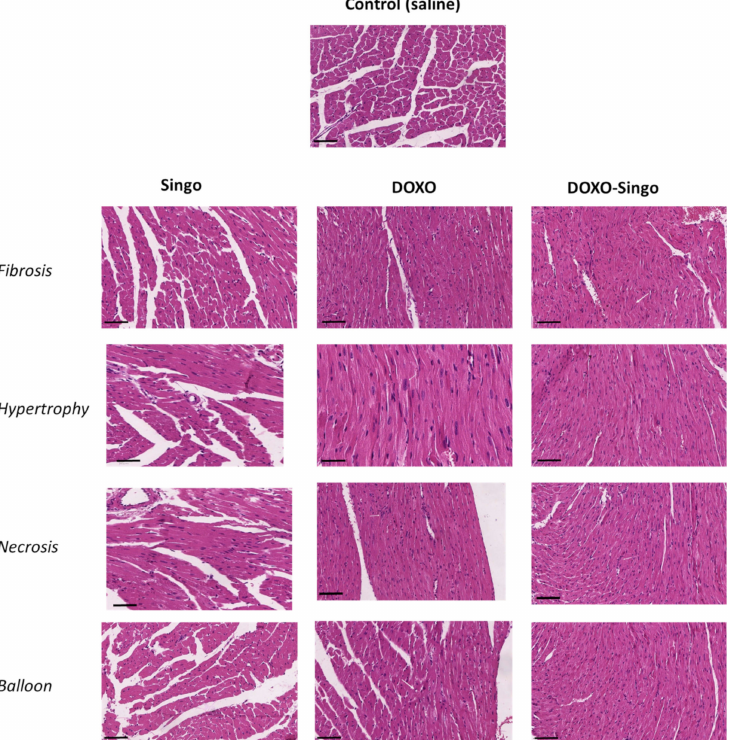
Figure 7. Histological study of cardiac tissues of mice not treated or treated with DOXO, Singo or both in combination. At the end of the experiment, after appropriate sacrifice, the tissues were analyzed for the evaluation of hypertrophy, fibrosis, necrosis and balloon. Scale bar: 50 µ m.